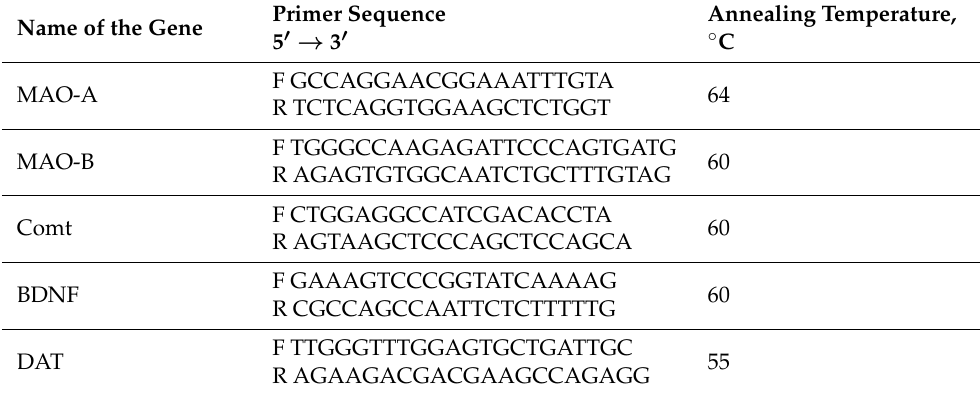
Table 3. The primer